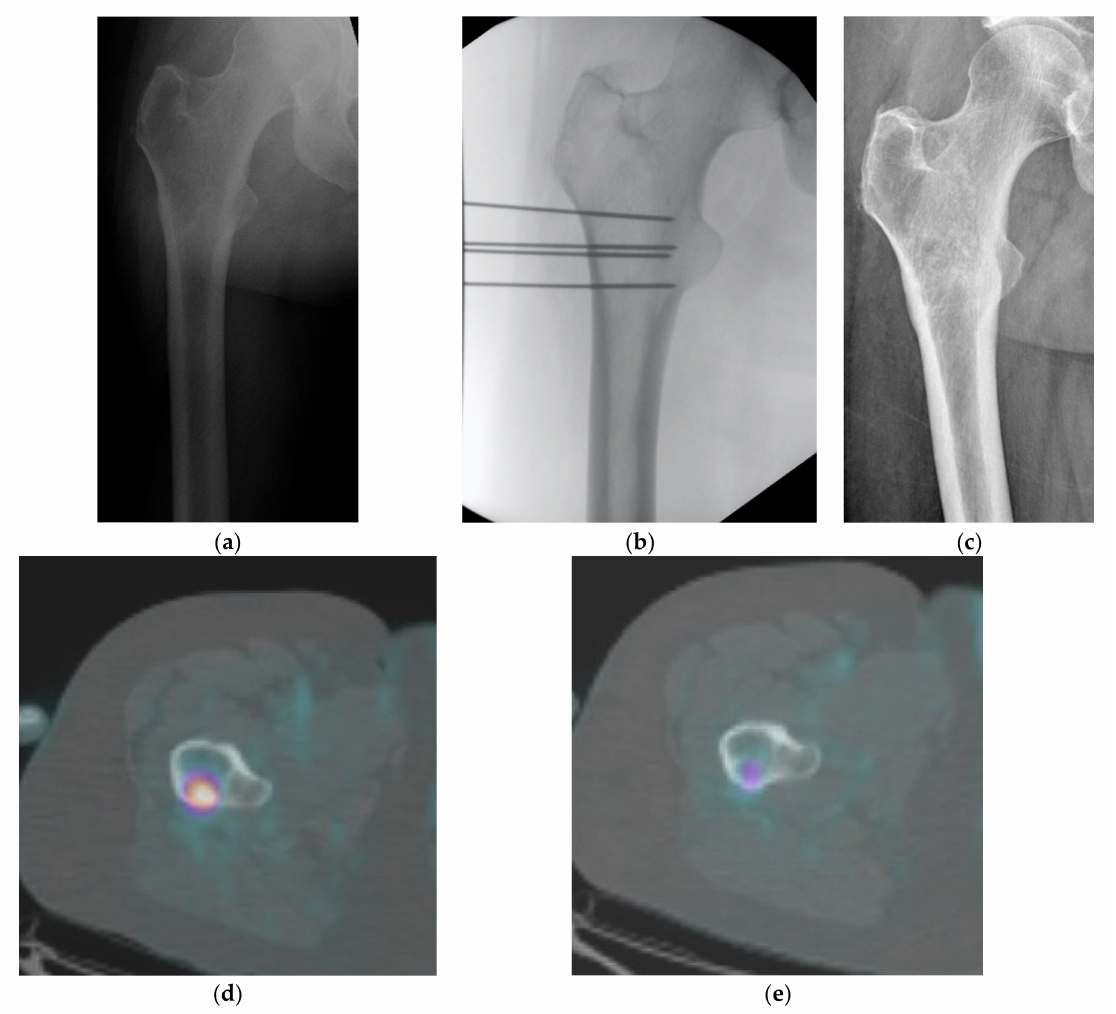
Figure 1. ( a – e ) Woman 47 years old. Osteolytic lesions in proximal femur in bone metastasis from breast carcinoma treated with ECT. ( a ) Pre-op X-ray, ( b ) intraoperative fluoroscopic check, ( c ) 18 months of follow-up: pain decreased from VNS 9 to 0/10 and the lesion partially ossified. PET scan performed before ( d ) and 6 months after treatment ( e ) shows a partial metabolic response of the